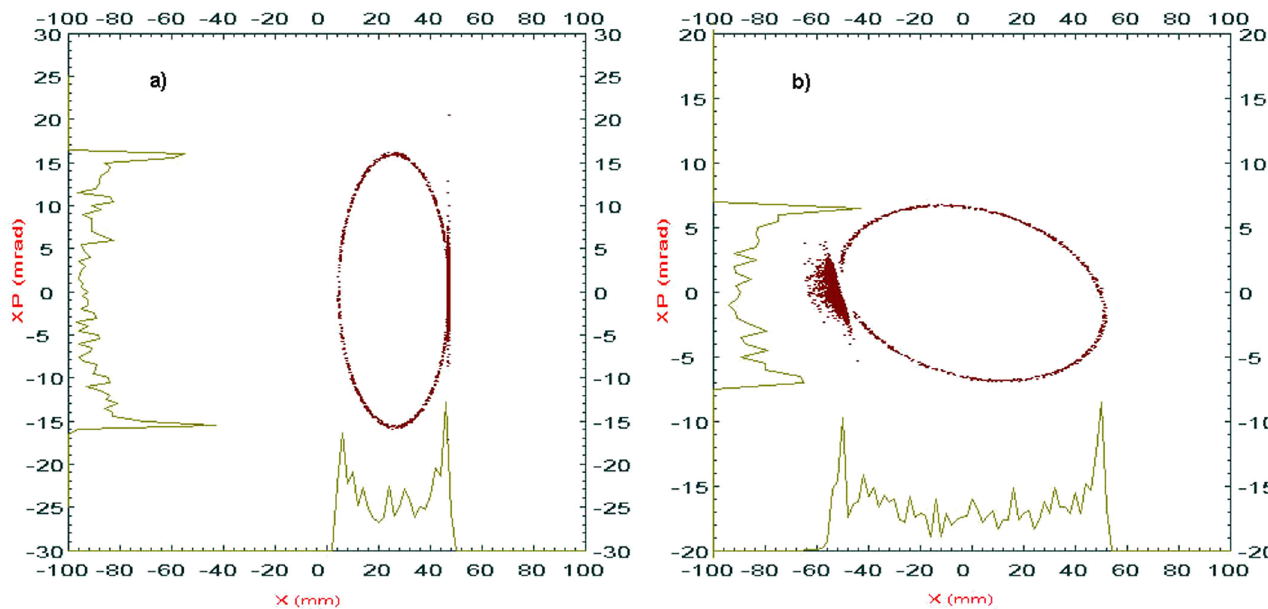
COMBINED MOMENTUM COLLIMATION STUDIES IN A . .